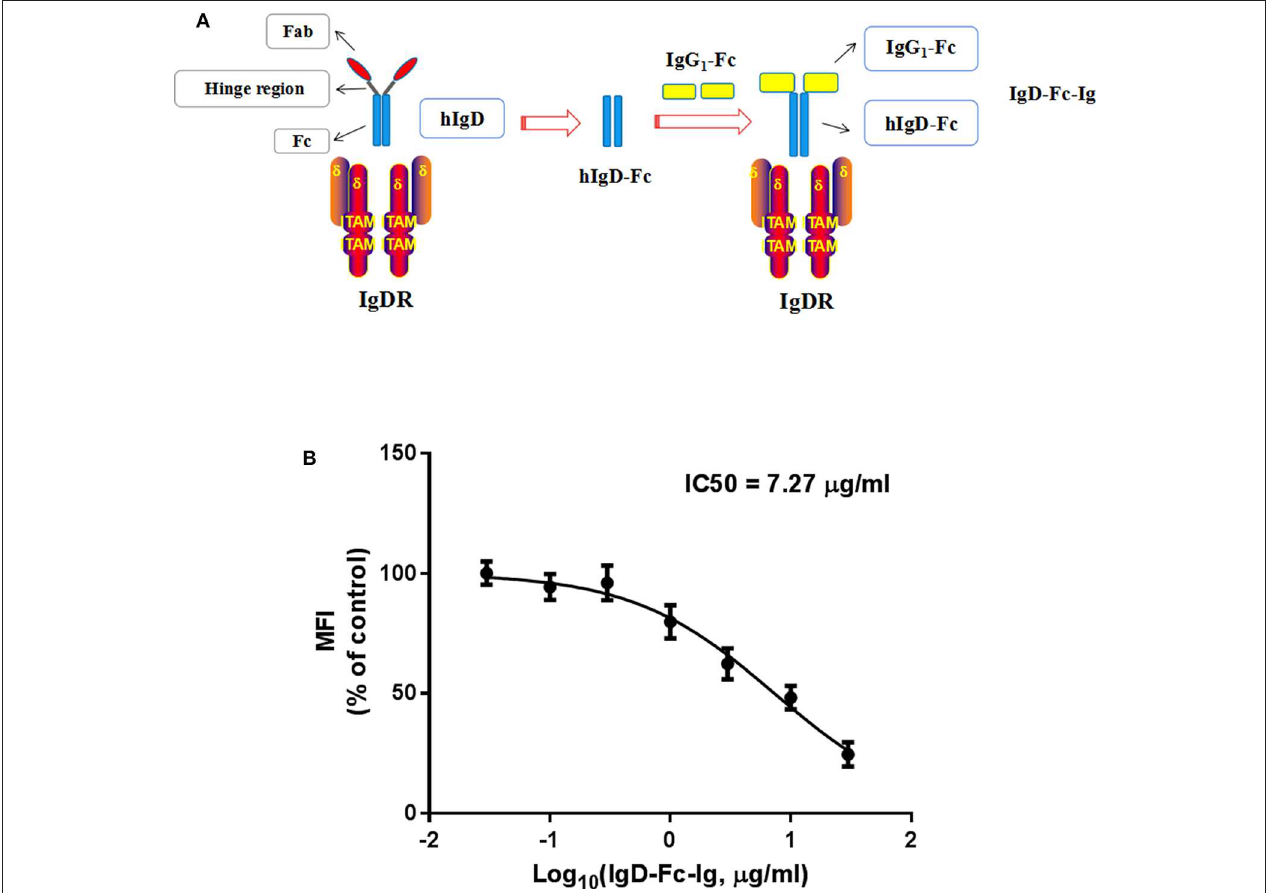
FIGURE 2 | The competitive binding assay of IgD-Fc-Ig to IgDR. (A) The schematic diagram of IgD-Fc-Ig structure. (B) The competitive binding curve of IgD-Fc-Ig to IgDR. CD4 + T cells were incubated with various concentrations of IgD-Fc-Ig (0.03, 0.1, 0.3, 1, 3, 10, 30 µ g/mL) and FITC labeled human IgD (10 µ g/mL) at 37 for 2h. The MFI of IgD binding to IgDR on CD4 + T cells was